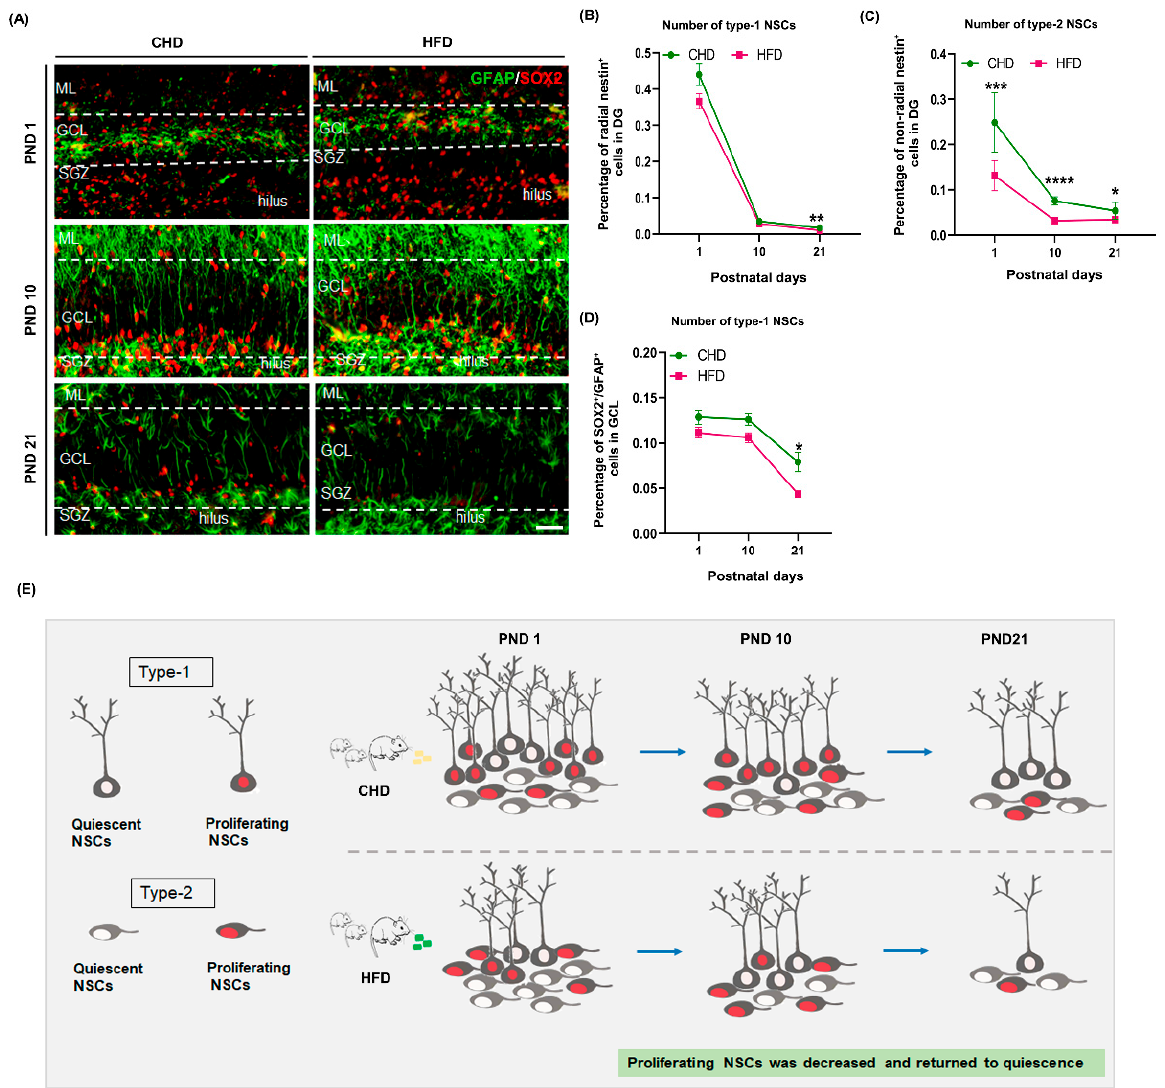
Figure 4. Maternal HFD leads to a decrease in type-2 NSCs during DG development. ( A ) GFAP (green)/SOX2 (red) immunostaining on PND 1, 10 and 21, scale bar = 50 µ m. ( B , D ) Quantification of type–1 NSCs (radial Nestin + cells and GFAP + /SOX2 + cells) on PND 1 ( n = 5), 10 ( n = 3) and 21 ( n = 4). ( C ) Quantification of type–2 NSCs (non-radial Nestin + cells) on PND 1 ( n = 5), 10 ( n = 3) and 21 ( n = 4). ( E ) Summary of effects of maternal HFD on two subtypes of NSCs during DG development. * p < 0.05, ** p < 0.01, *** p < 0.001, **** p < 0.0001 vs. CHD. NSCs, neural stem cells; PND, postnatal day; ML, molecular layer; GCL, granular cell layer; SGZ, subventricular zone; GFAP, glial fibrillary acidic